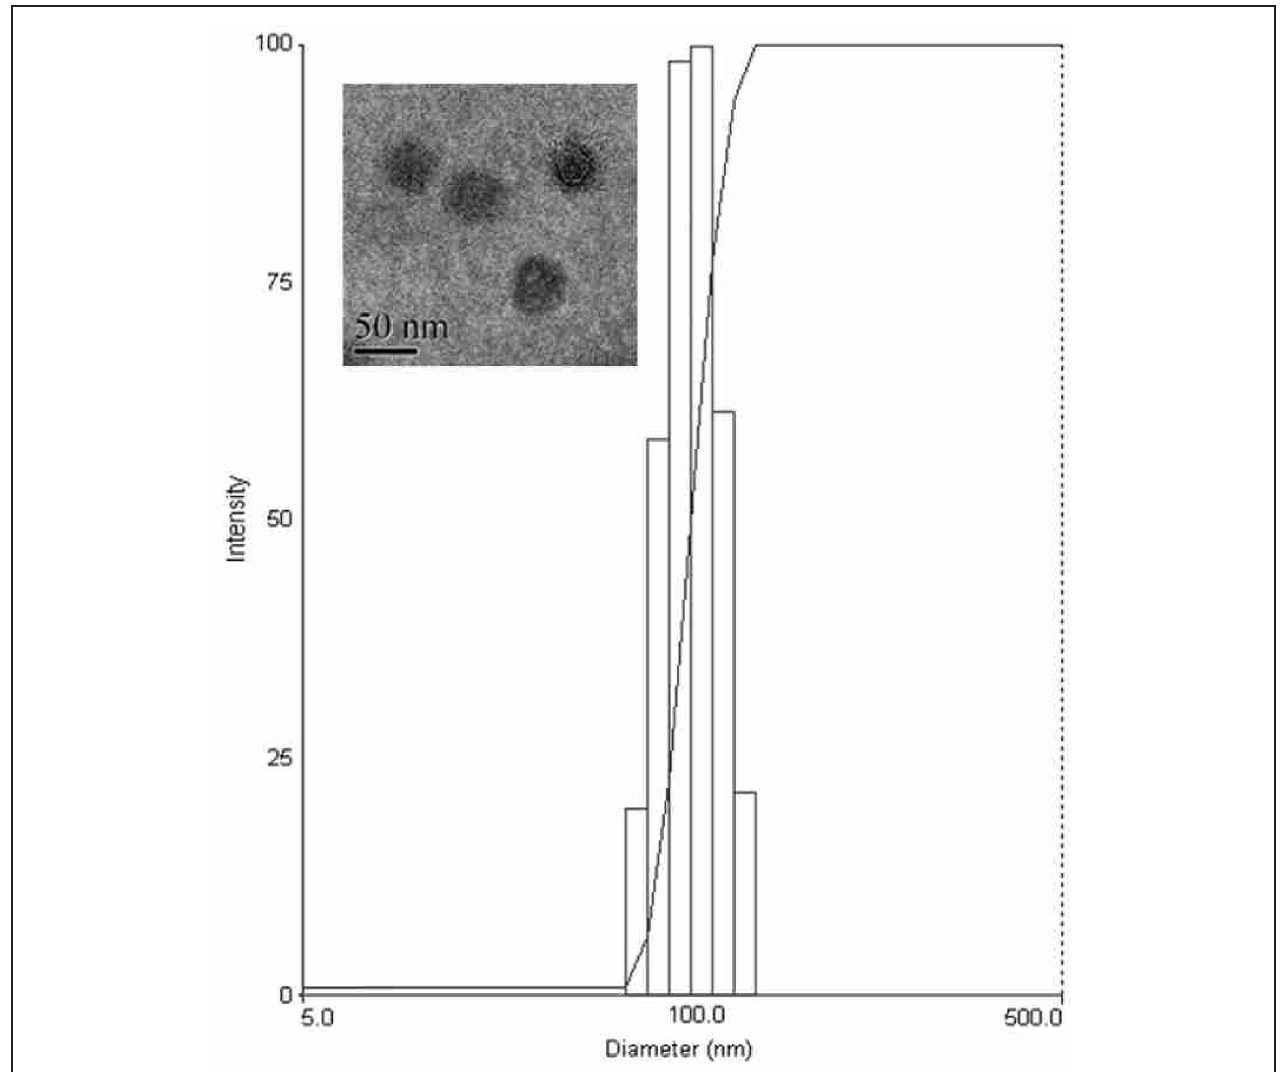
FIGURE 3 | Size distribution and transmission electron microscopy (TEM) image of